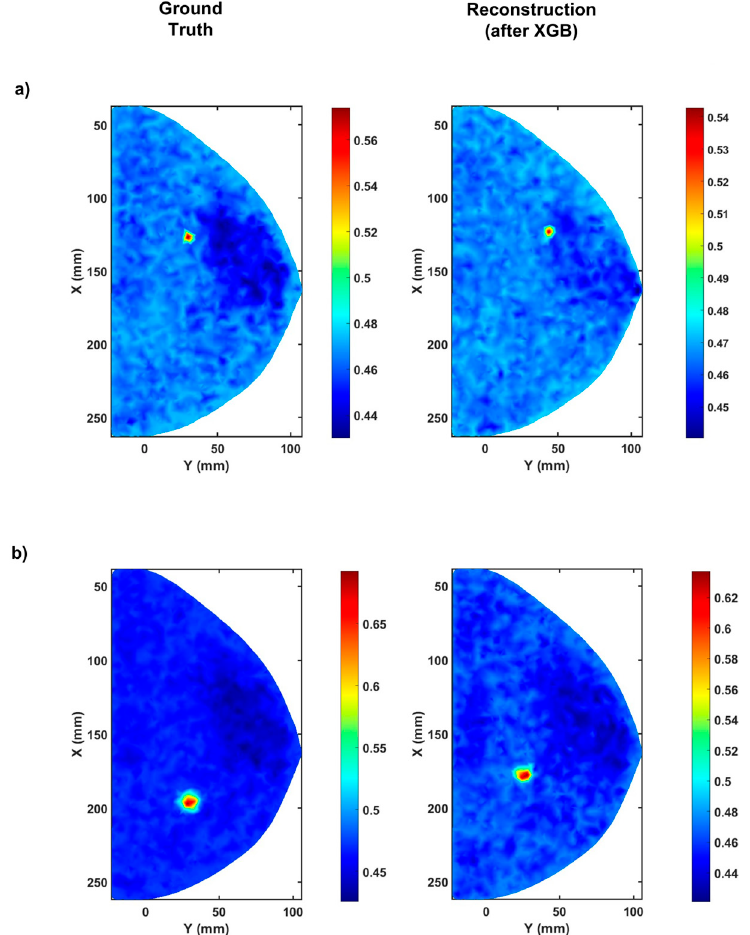
Figure 2. The reconstructed tumor locations using predictions from the XGBoost machine learning algorithm. ( a ) showing the reconstructed tumor locations at ( z = 5.325 mm), and ( b ) showing the reconstructed tumor locations at ( z = 11.289 mm), are two different examples of the XGBoost predictions. The color bar shows the absorption coefficient in (cm − 1